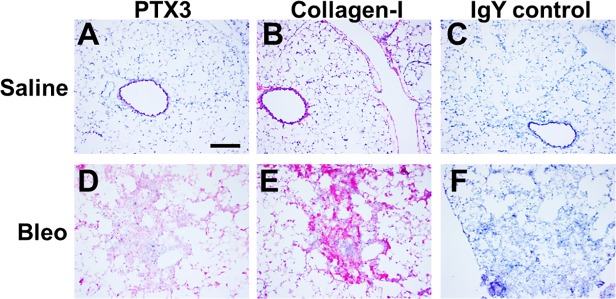
Distribution of PTX3 in mouse lungs following bleomycin aspiration.Cryosections of mouse lungs 21 days after A-C) saline or D-F) bleomycin aspiration were incubated with antibodies against A and D) PTX3, B and E) collagen-I, or C and F) control rabbit antibodies Sections were counterstained with hematoxylin. Bar is 0.2 mm. Images are representative of 3 independent experiments.